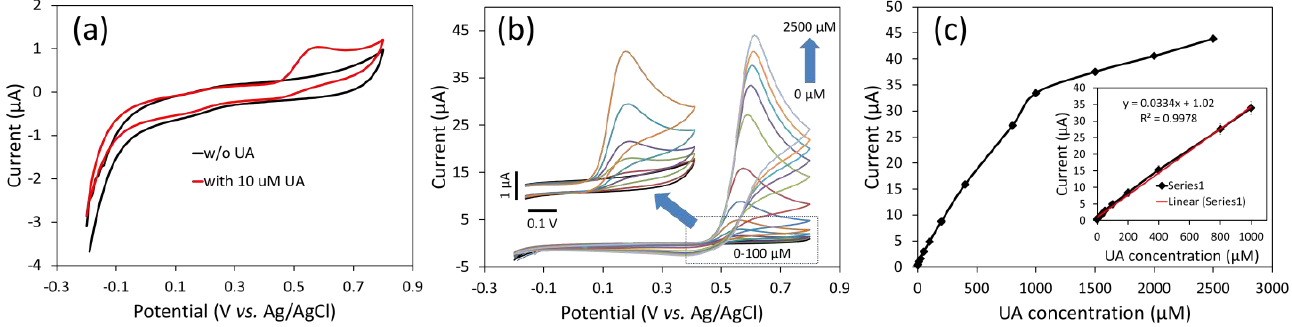
Figure 5. ( a ) CV response curves recorded for cobalt oxide/GCE electrode in PBS without and with uric acid (10 µM) at 50 mV/s, ( b ) CV responses of cobalt oxide/GCE electrode with increasing uric acid concentrations (0 − 2500 µM), and ( c ) plot of current response vs. uric acid concentration showing linear and non − linear regions. Inset b shows the magnified CV response curves for low- concentration uric acid. Inset c shows the calibration plot of the linear region (i.e., response vs. uric acid concentration).